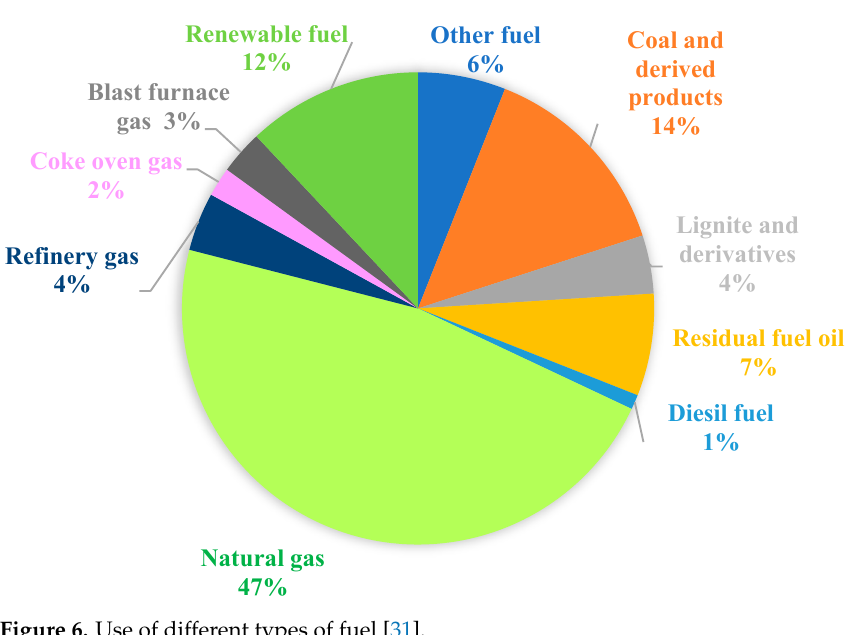
Figure 6. Use of different types of fuel [31].